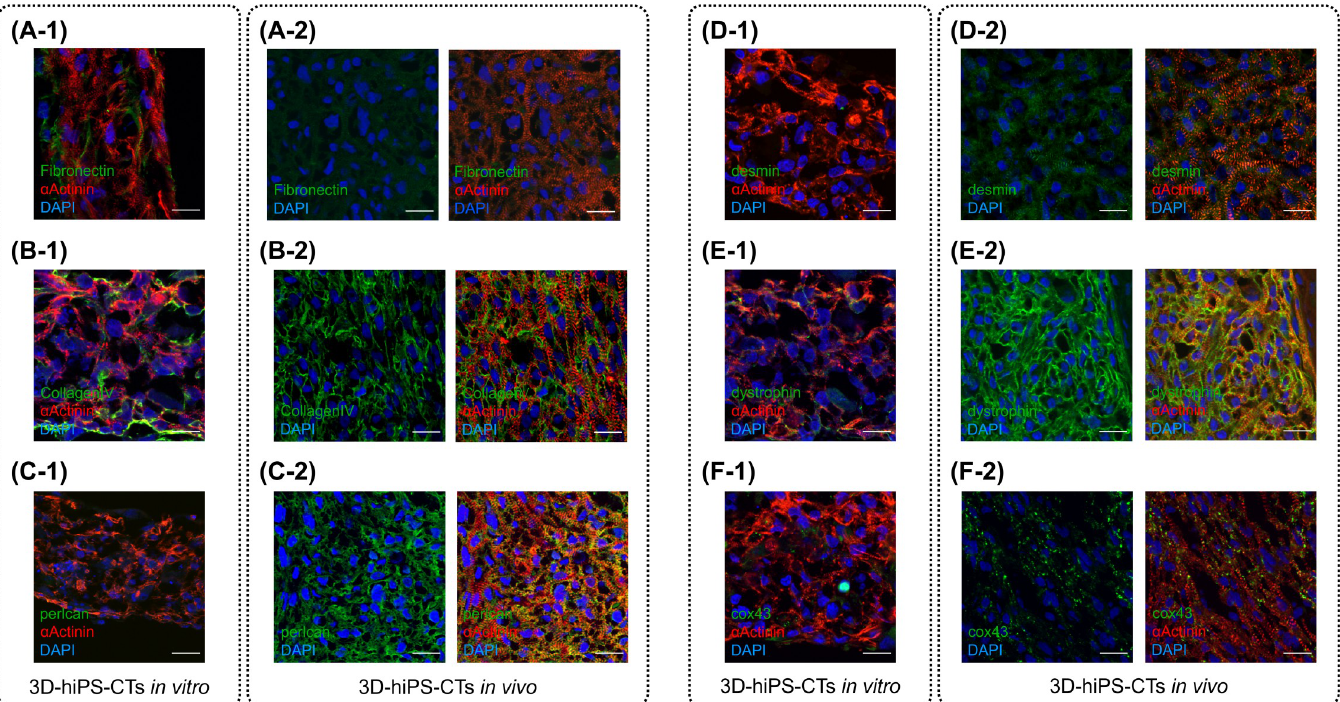
Fig 6. Implantation of three-dimensional human induced pluripotent stem cell-derived cardiac tissue (3D-hiPSC-CT) promoted extracellular matrix (ECM) remodeling and maturation of cardiomyocytes. (A-1) Immunostaining of fibronectin (green) on 3D-hiPSC-CT in vitro . (A-2) Fibronectin expression (green) was poor in the cardiac tissue 12 weeks after transplantation. (B-1) Immunostaining of collagen IV (green) on the 3D-hiPSC-CT in vitro . (B-2) Collagen type IV (green) was clearly expressed in the transplanted tissue 12 weeks after implantation. (C-1) Immunostaining of perlcan (green) was not observed on the 3D-hiPSC-CT in vitro . (C-2) Perlcan (green) was clearly expressed in the transplanted tissue 12 weeks after implantation. (D-1) Immunostaining of desmin (green) was not observed on the 3D-hiPSC-CT in vitro . (D-2) Desmin (green) was expressed in the transplanted tissue. (E-1) Immunostaining of dystrophin (green) was not observed on the 3D-hiPSC-CT in vitro . (E-2) Dystrophin (green) was clearly expressed in the transplanted tissue. (F-1) The expression of connexin43 (green) was poor on the 3D-hiPSC-CT in vitro . (F-2) Connexin43 (green) was clearly expressed in the transplanted tissue 12 weeks after